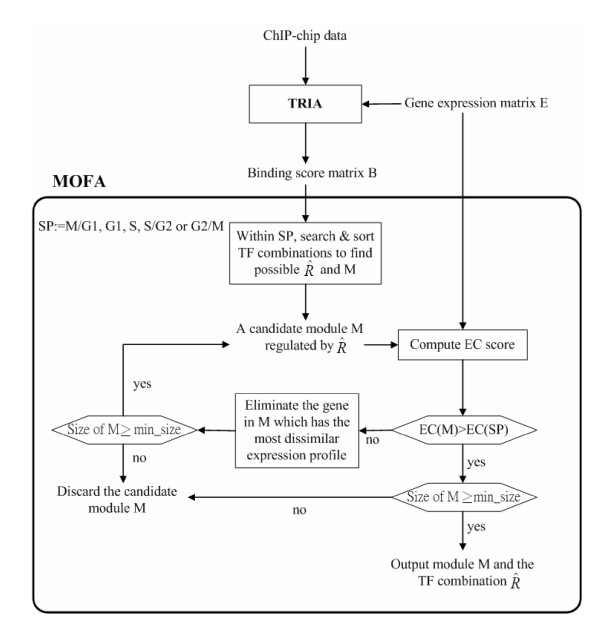
Flowchart of MOFA.